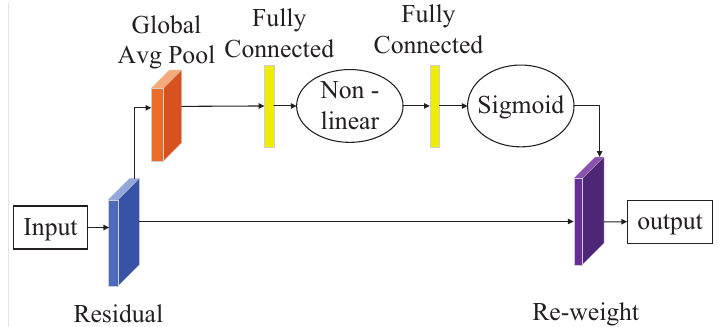
Figure 3. Structure of the SE attention